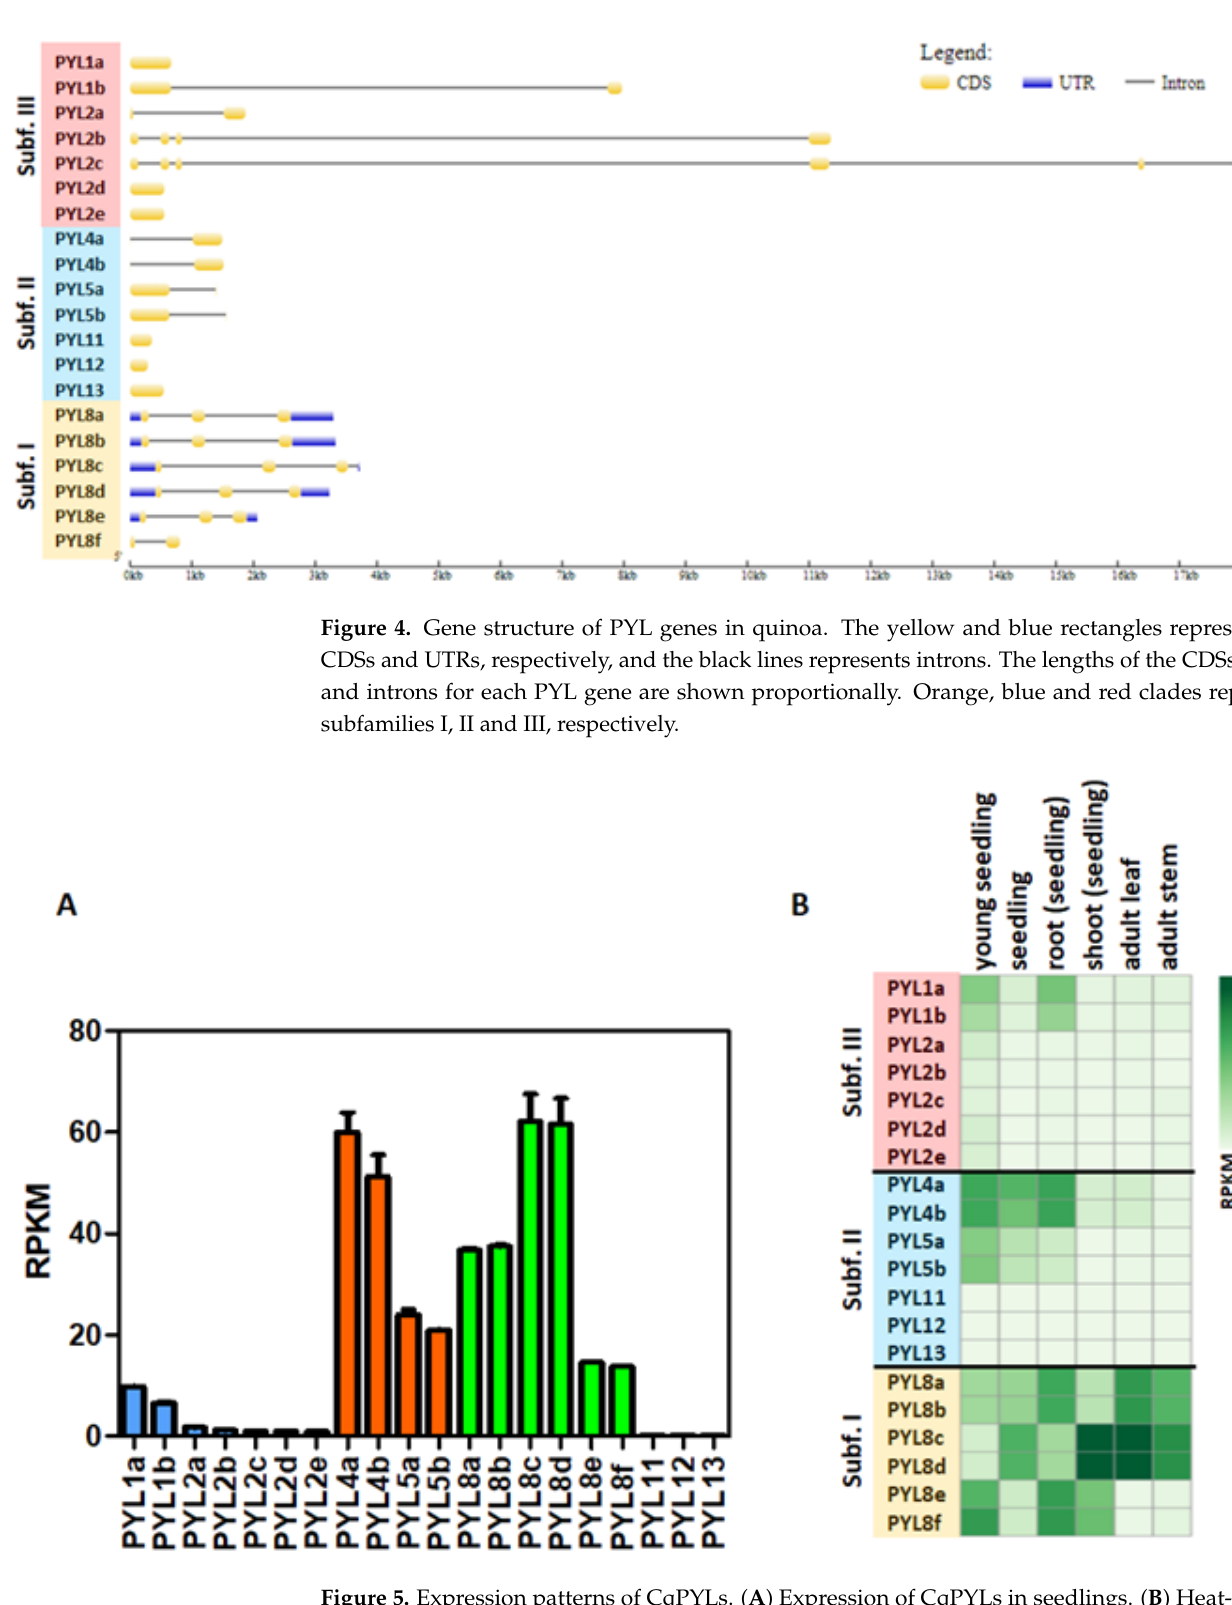
Figure 5. Expression patterns of CqPYLs. ( A ) Expression of CqPYLs in seedlings. ( B ) Heat-map of CqPYLs expression data from different tissues. RNA-seq samples from SRA-NCBI of different tissues were analyzed. The RPKM (reads per kilo base of transcript per million fragments mapped reads) value of each CqPYL was calculated and